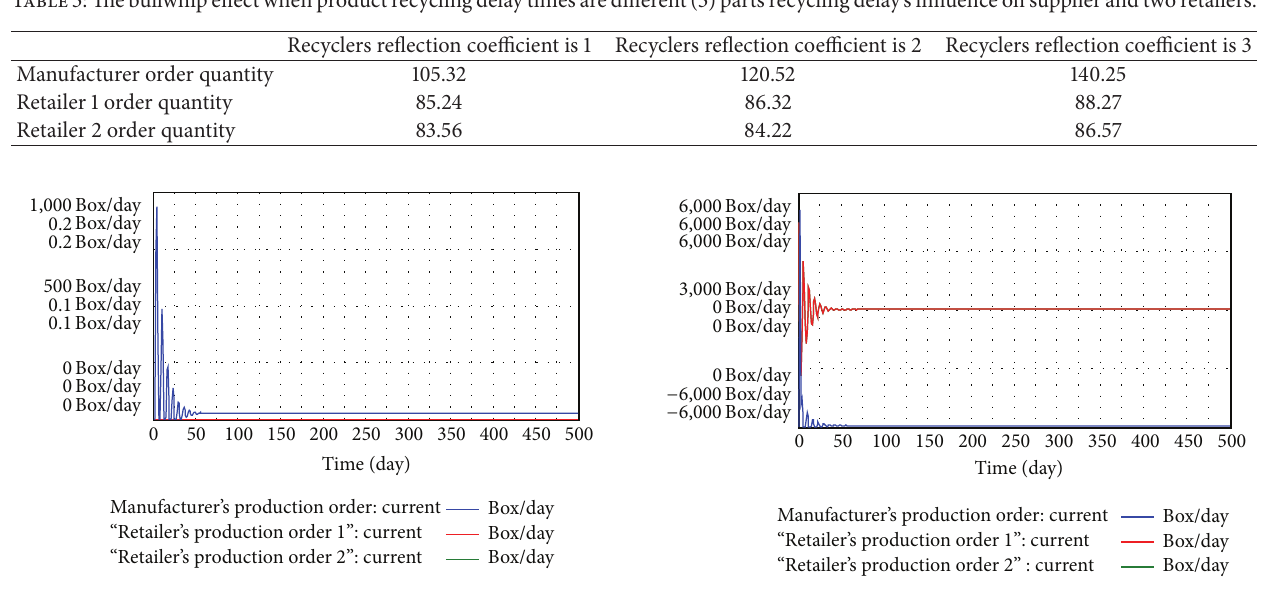
Figure 8: The members’ order quantity changes when recycler reaction coefficient is 3.